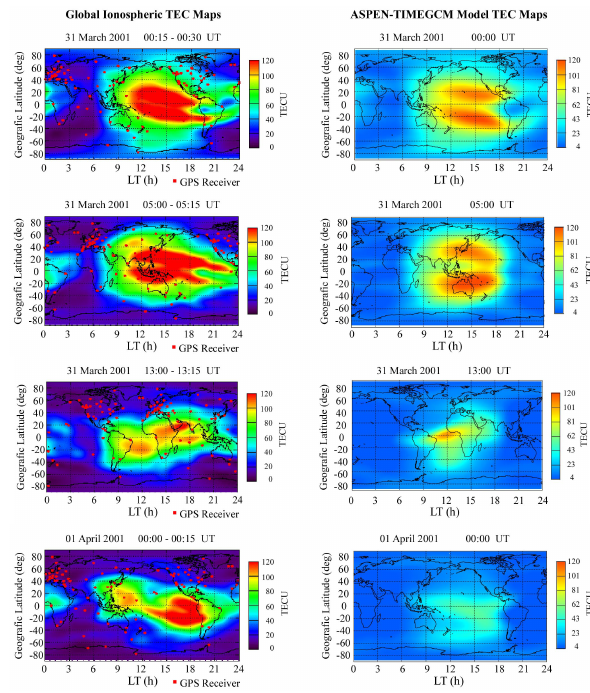
Figure 5 Fig. 5. Global ionospheric TEC maps obtained from GPS network for the time periods 00:15–00:30 UT, 05:00–05:15 UT and 13:00– 13:15 UT on 31 March and 00:00–00:15 UT on 1 April 2001.